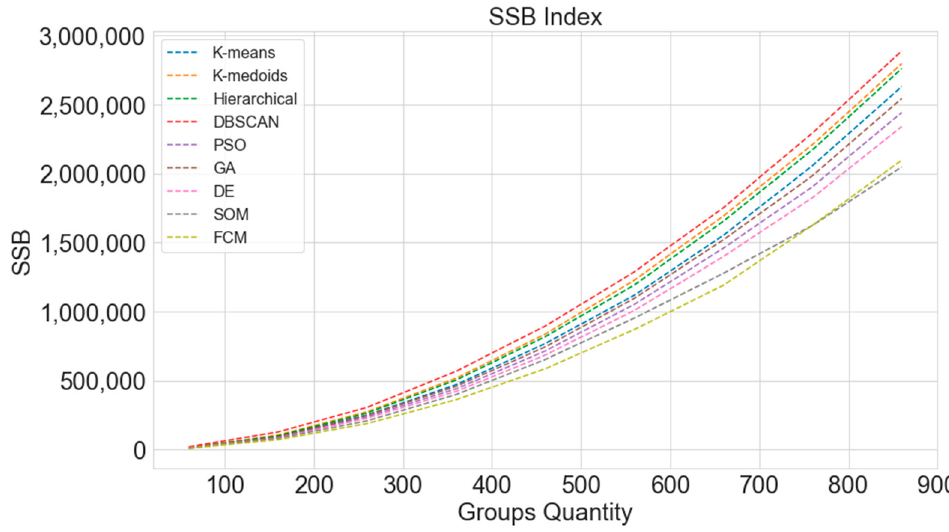
Figure 8. SSB index evaluation over different group amounts considering nine clustering methods.